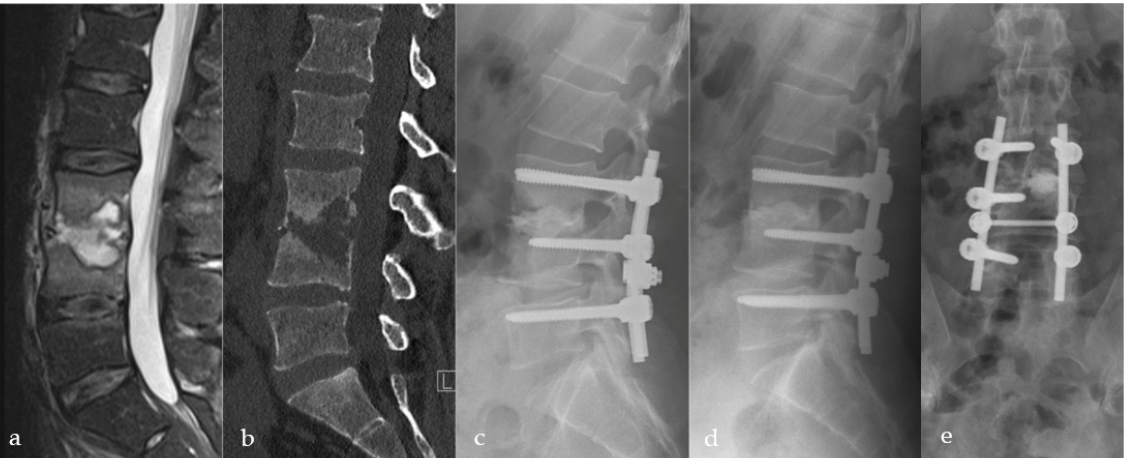
Figure 3. Thirty-eight-year-old male patient suffering from severe erosive spondylodiscitis with a ~40% bony defect in L3/4. Preoperative MRI and CT scans are shown in images ( a , b ). Immediately postoperatively ( c ) and one-year postoperatively ( d ) lateral and ( e ) a.p. X-rays show bony regeneration and clinical infection consolidation in the affected segment L3/4. L5 was included in the stabilization due to a weak bony situation during the operation to provide sufficient stability.